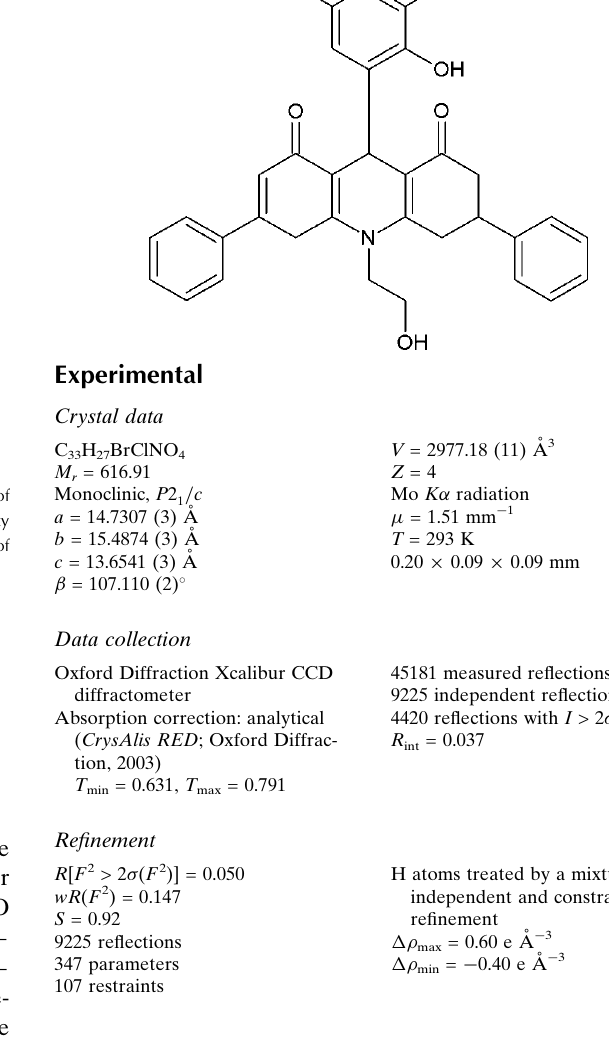
Hydrogen-bond geometry (A˚ , (cid:3)